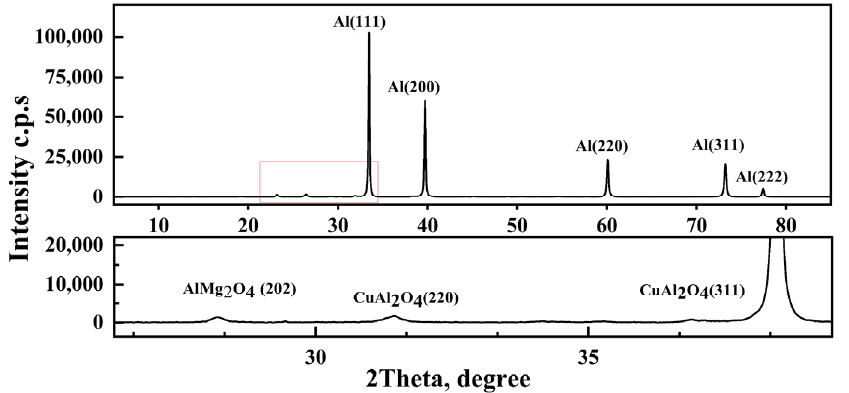
Figure 4. A typical X-ray pattern of CNTs/Al − Mg − Si alloy composite.